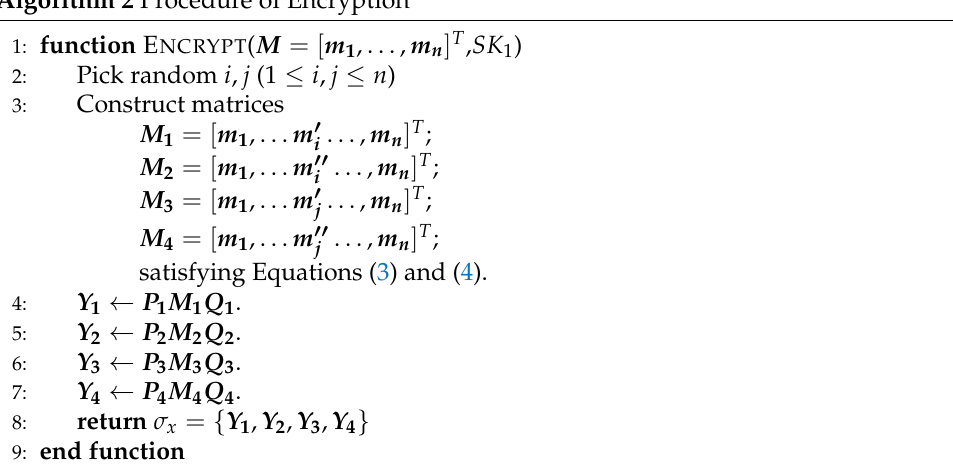
Algorithm 2 Procedure of